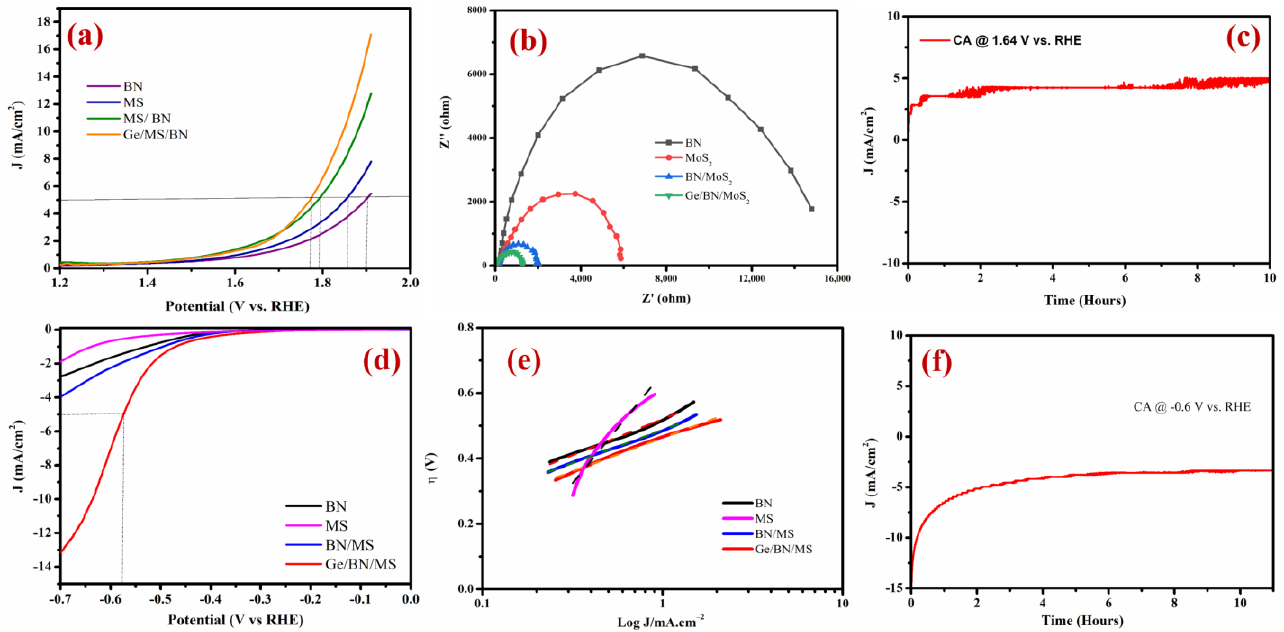
Figure 6. Electrocatalytic performance ( a ) OER, ( b ) EIS, ( c ) CA of h-BN/MoS 2 , ( d ) HER, ( e ) Tafel, and ( f ) CA of Ge/h-BN/MoS 2 nanohybrid. The dotted lines are fitted curve of the tafel slope.